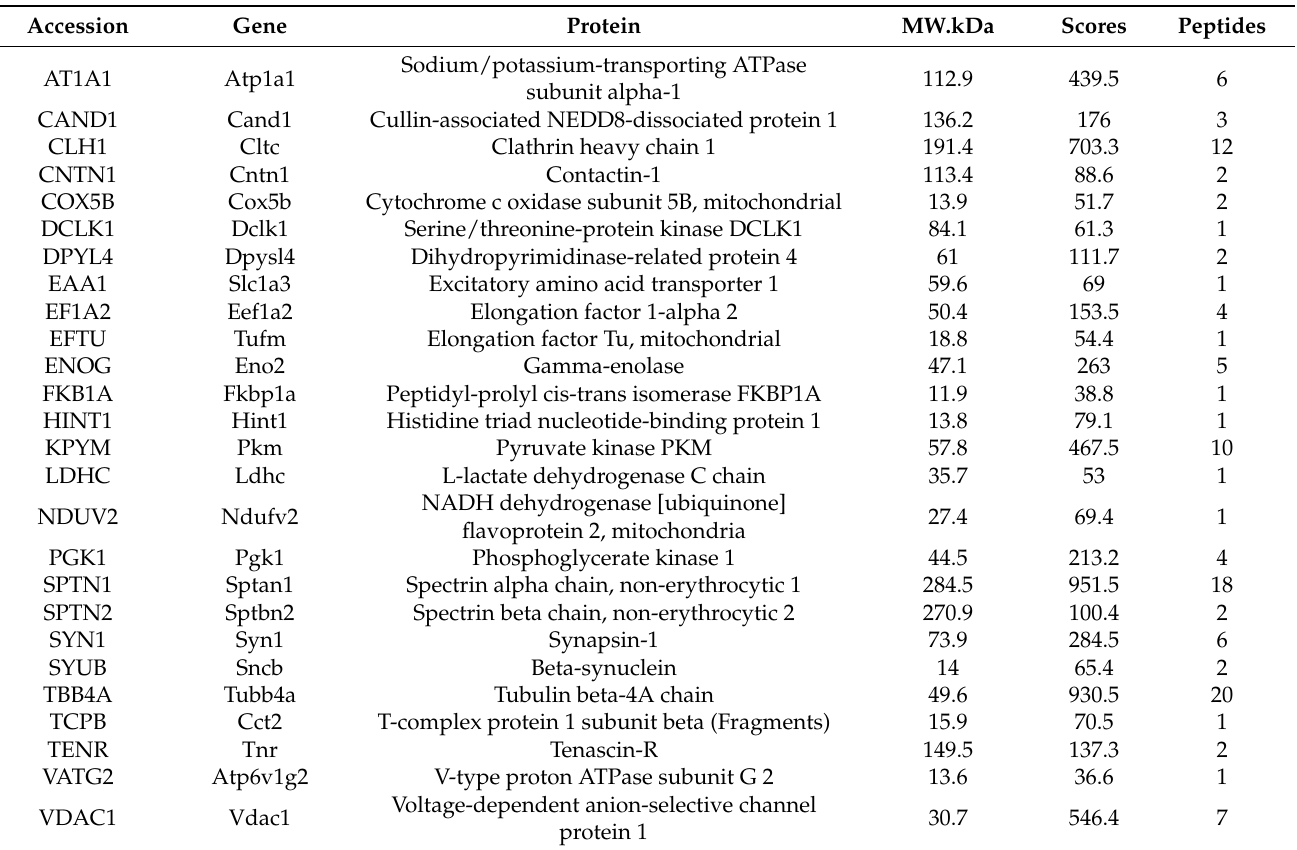
Table 2. The list of 26 proteins identified in the adult medial prefrontal cortex of the female rats in the proteomic analysis. For each protein match, Mascot calculates an overall Protein Score. This number reflects the combined scores of all observed mass spectra that can be matched to amino acid sequences within that protein. A higher score indicates a more confident